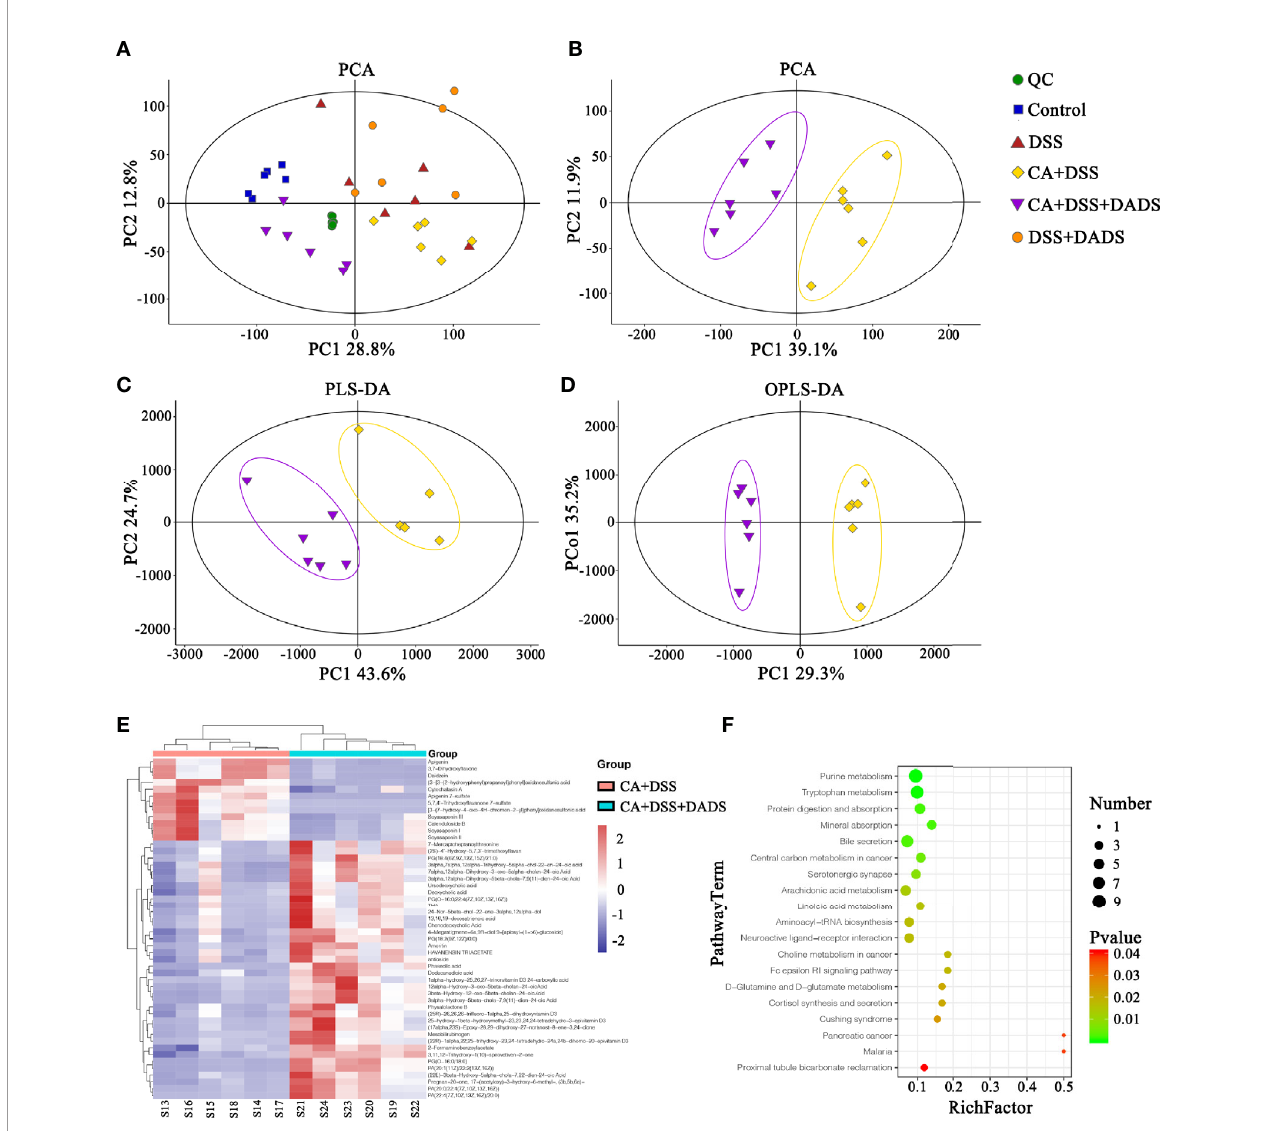
FIGURE 8 | Effect of DADS on fecal metabolites in mice with C. albicans infection. The (A, B) PCA, (C) PLS-DA, and (D) OPLS-DA models in different groups. (E) Heatmaps of differentially altered metabolites between the two groups. (F) Differential metabolic pathways visualized in bubble plots ( P < 0.05); the bubble size represents the number of metabolites, n =